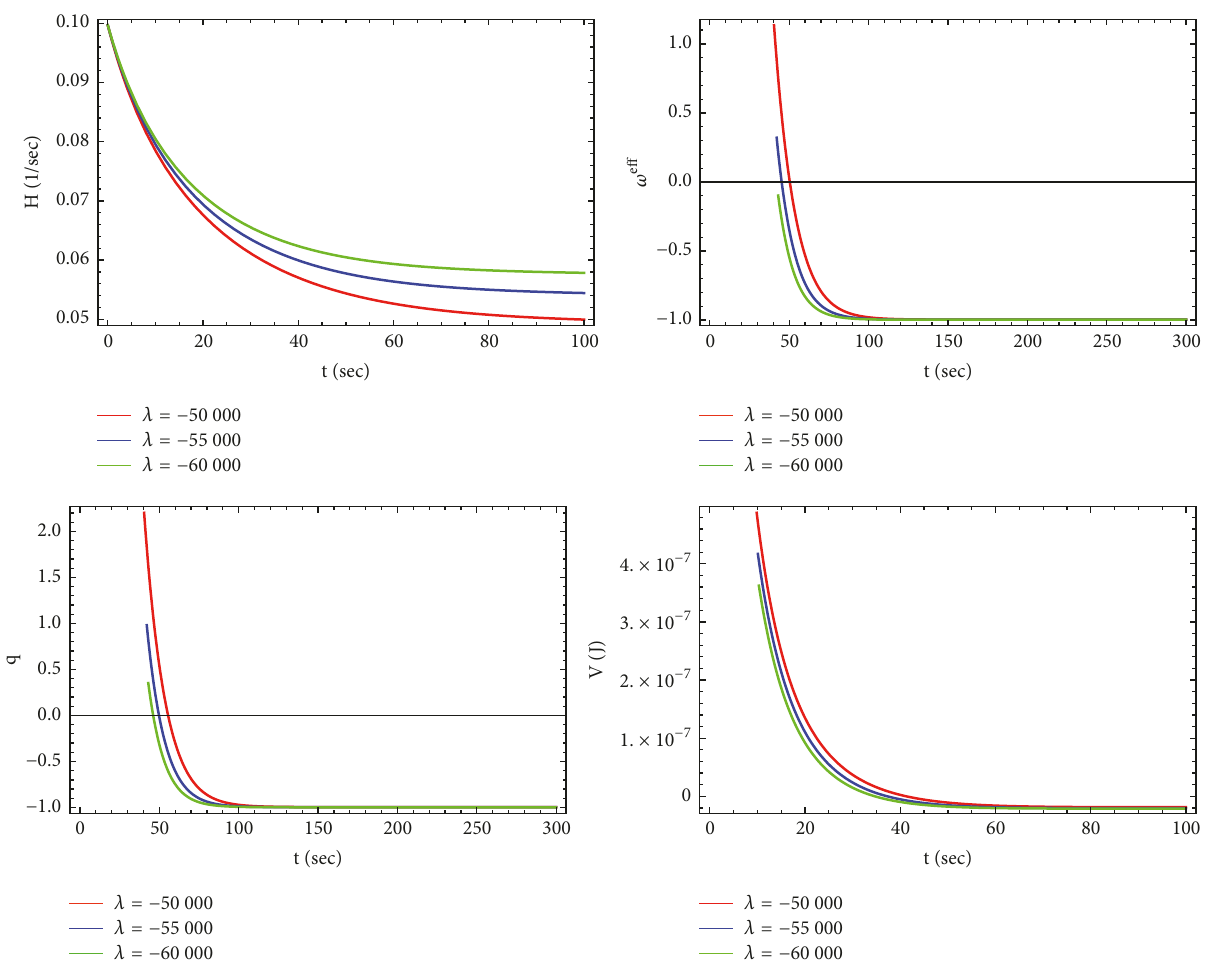
Figure 5: Plots of 𝐻 , 𝜔 𝑒𝑓𝑓 , 𝑞 , and 𝑉 versus 𝑡 for 𝑊(𝜑 − ) = 𝑏 2 ((𝜑 − ) 2 /3 − 𝜑 − ) , 𝑏 2 = −1(1/𝑠𝑒𝑐) , and 𝜑 − (0) = 0.1 when 𝑘 = 1 .